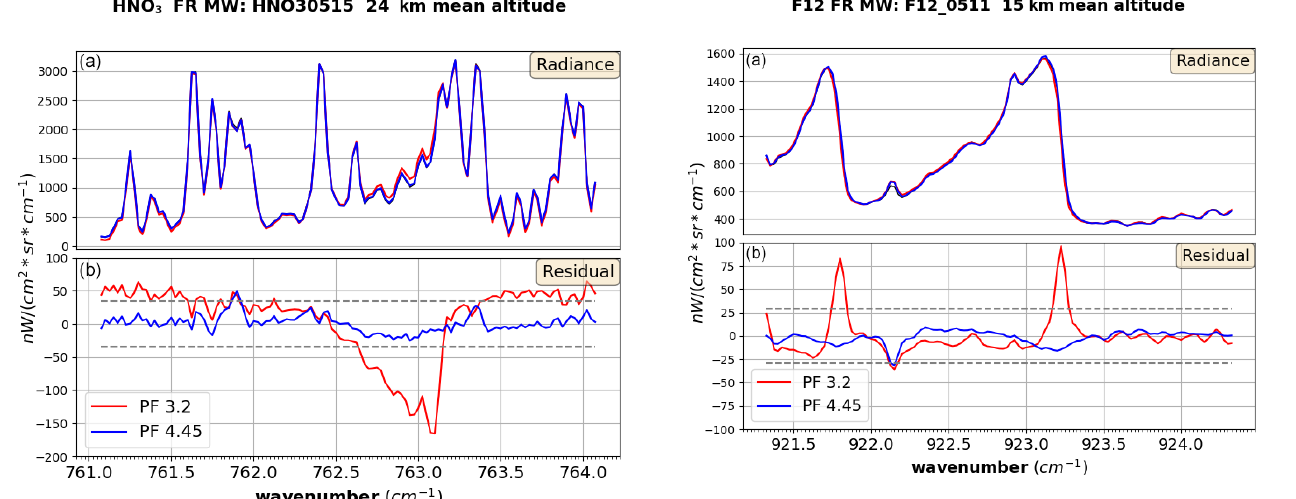
Figure 9. (a) Observed spectrum (black curve, under the blue one) and simulations at 15km with the old and the new spectroscopic pa- rameters for a microwindow used for CFC-12 retrieval of FR mea- surements. (b) Residuals obtained with simulations generated with the old spectroscopic database (red curve) and the new one (blue curve), compared with the measurement noise (grey